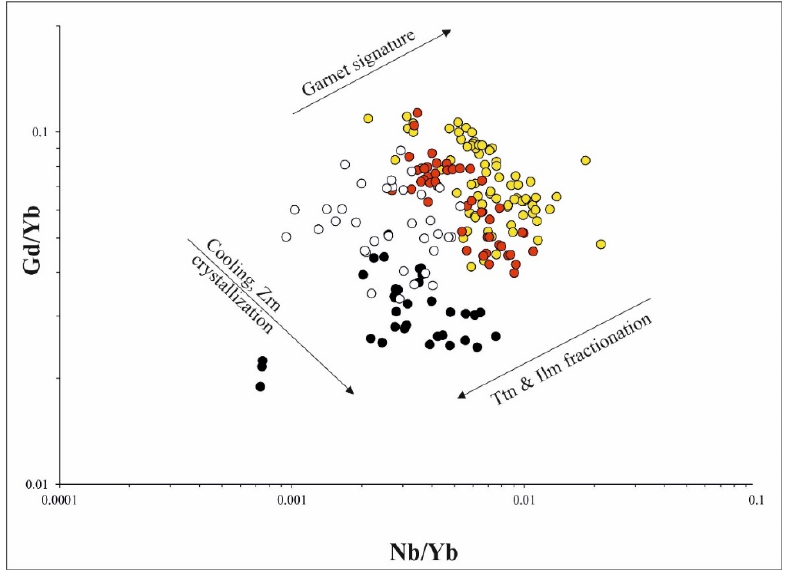
Figure 11. Gd/Yb vs. Nb/Yb diagram according to [57]. Symbols as in Figure 7.